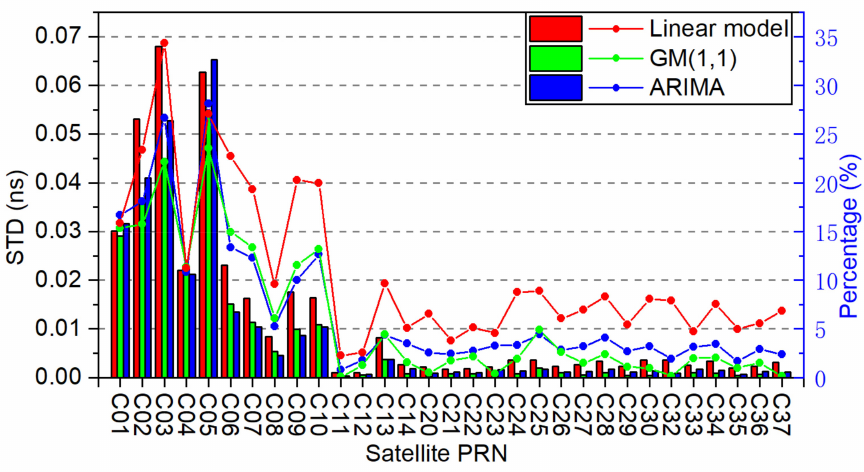
Figure 8. Average clock STD improvement and the percentage of each satellite with the three